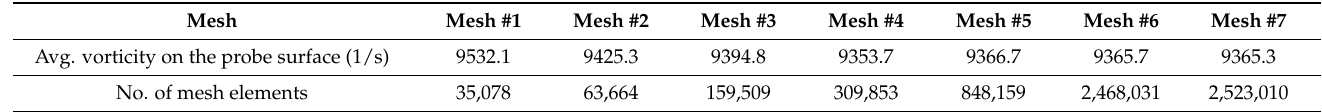
Table 1. Mesh-dependent convergency study. Results converged after Mesh #5; mesh #7 was selected to achieve the optimal runtime and